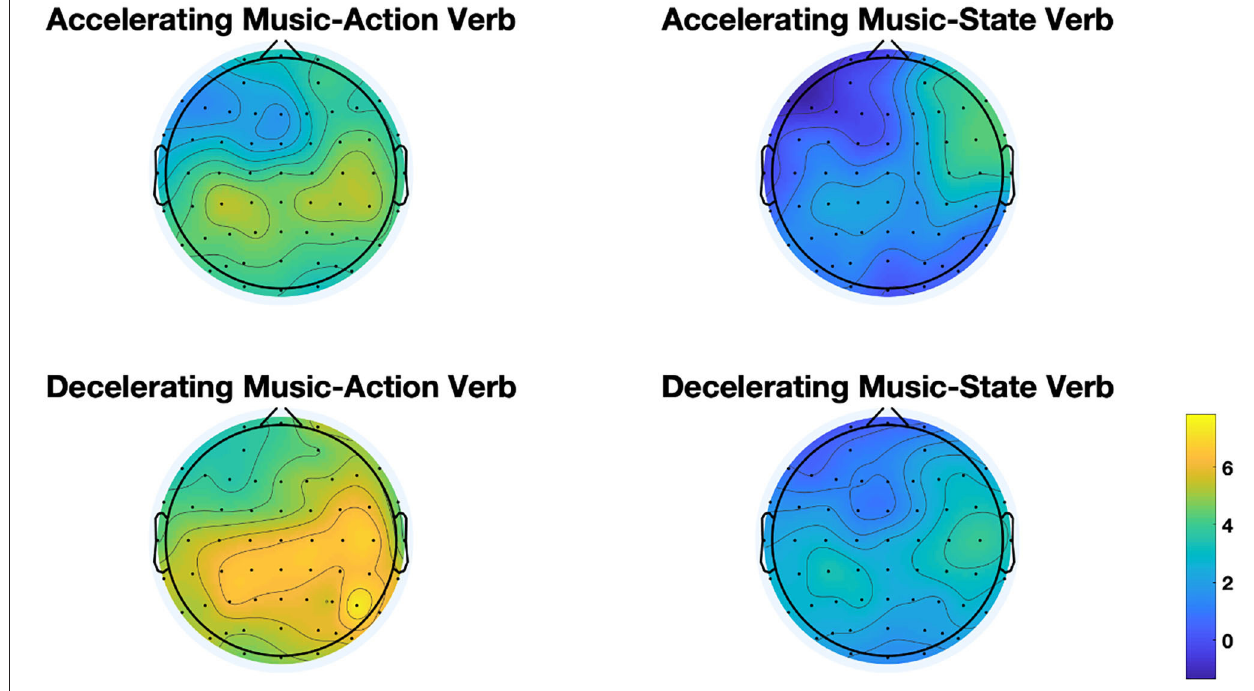
FIGURE 5 | Scalp topographic maps of N400 across four conditions in Task